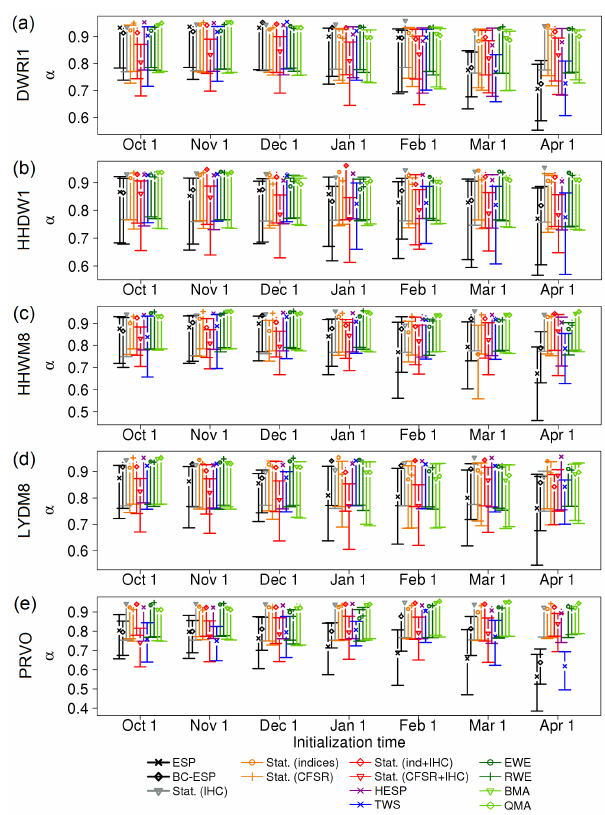
Figure 10. The α reliability index for the hindcast ensembles at the five case study locations. See text for further